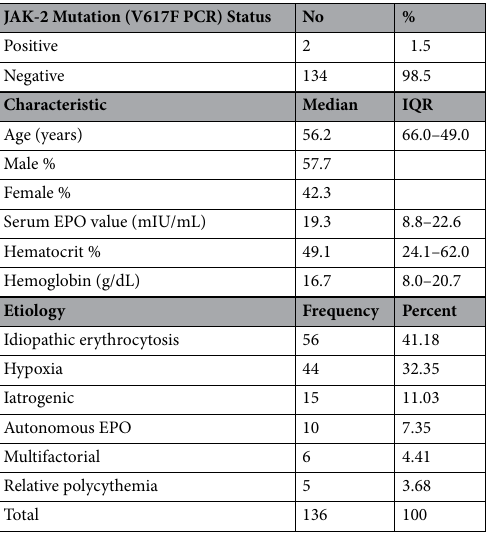
Table 1. Demographic and laboratory characteristics of 136 patients with a diagnosis of secondary erythrocytosis at MDACC. IQR: Interquartile Range. EPO: